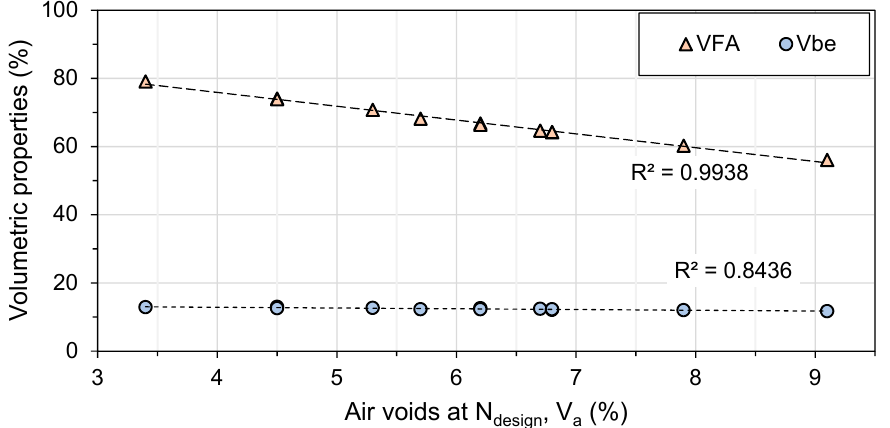
Figure 7. Effective volume of asphalt binder (V be ) and voids filled with asphalt (VFA) in the function of the air voids (V a ) at N design .